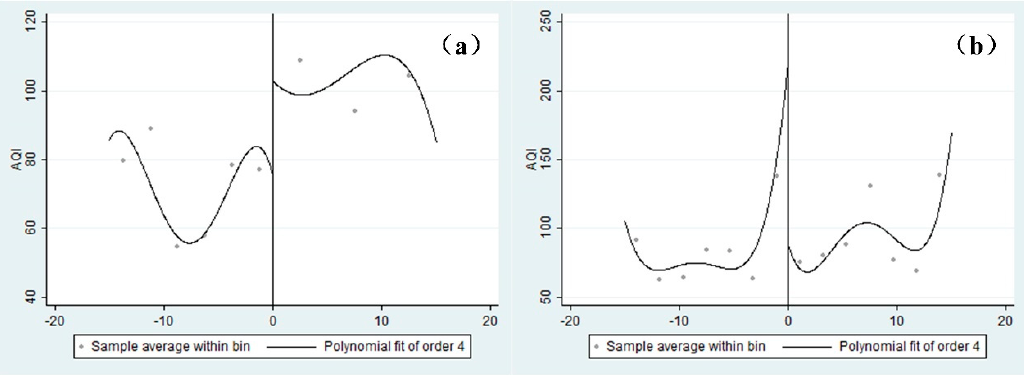
Figure 5. The results of the RD of AQI in Policy 2 and Policy 3: ( a ) AQI in Policy 2; ( b ) AQI in Policy 3.